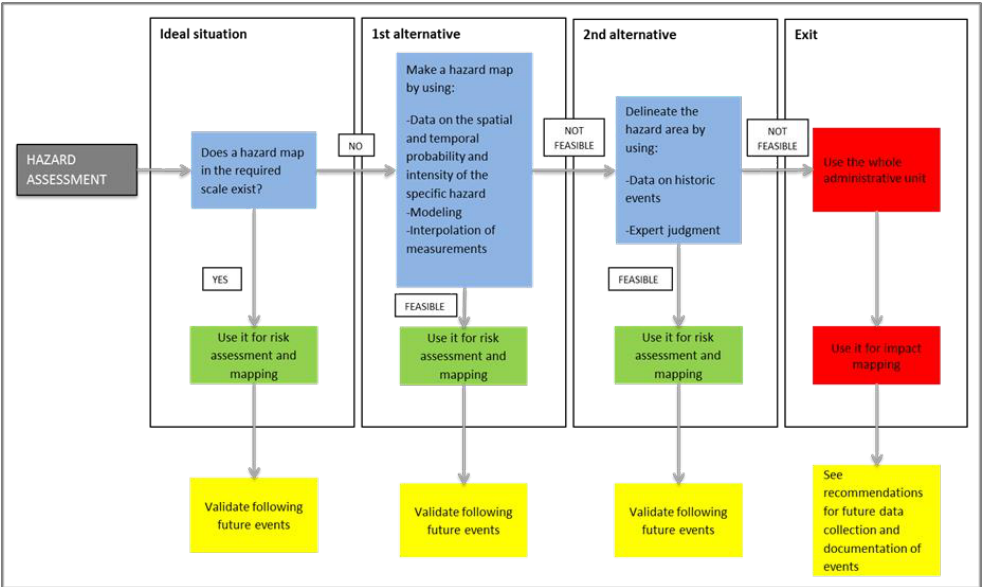
Figure 8. Quantitative hazard assessment using alternative steps [46].